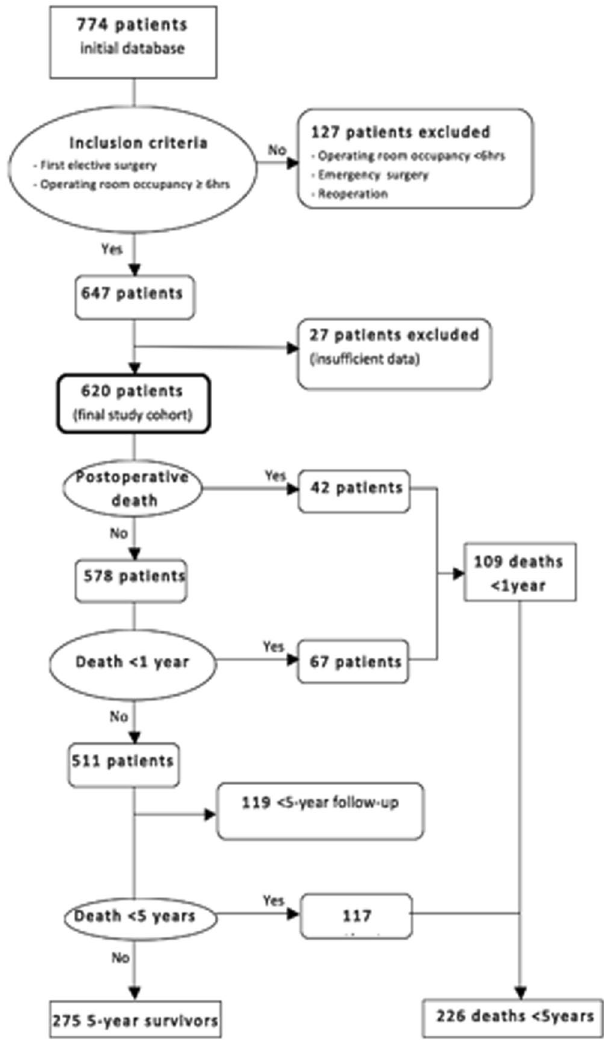
Figure 1. Flow chart of patients included in the